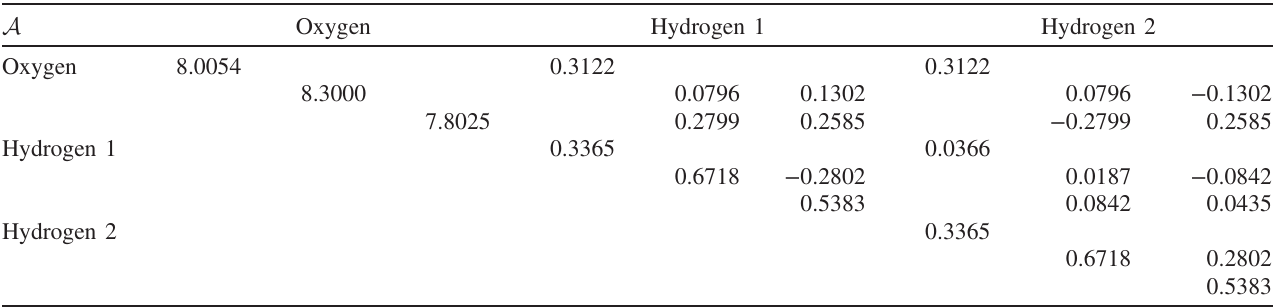
TABLE II. The A matrix for the molecule H 2 O at the equilibrium geometry [ r (17) yields (10.0004, 9.9997, 9.9999) for i , j ¼ xx , yy , zz , as the system contains 10